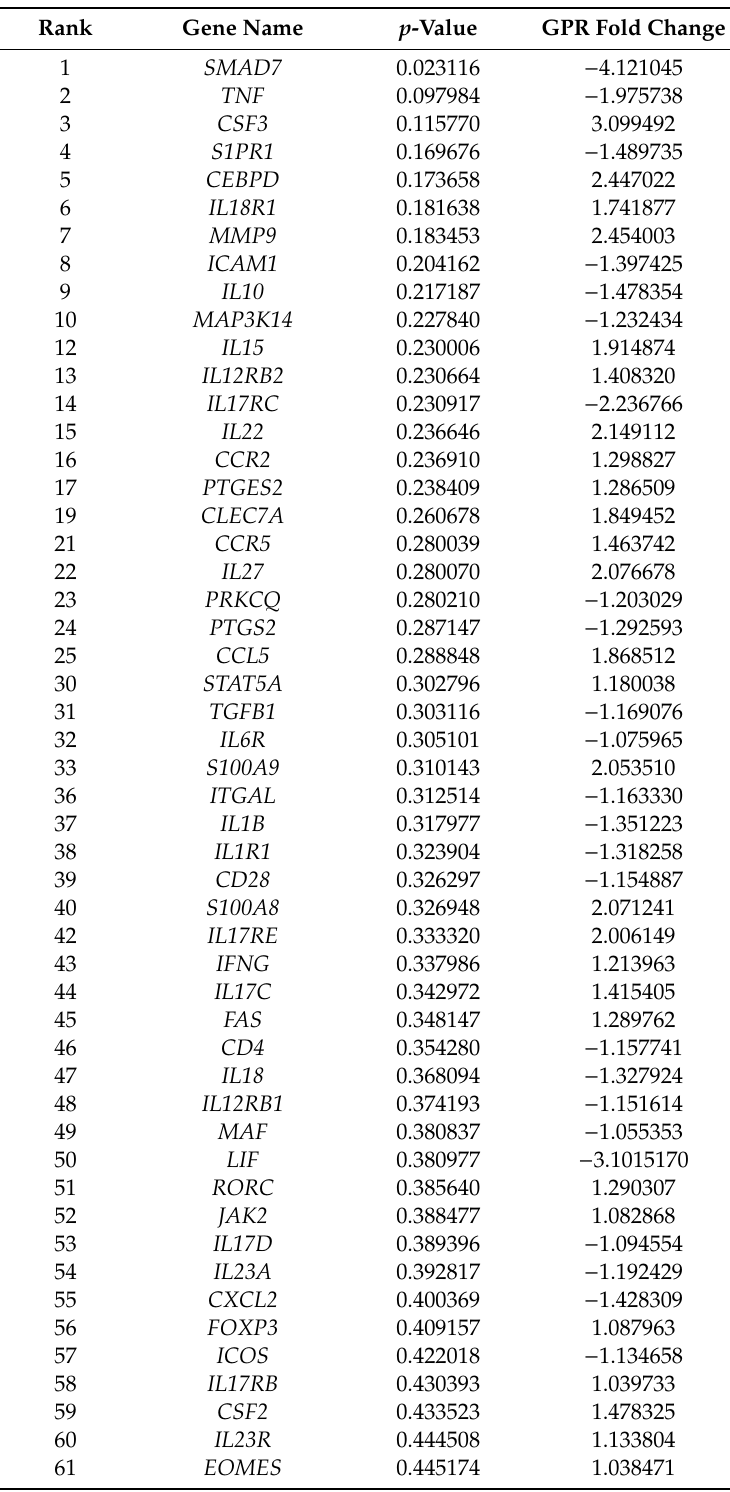
Table A1. Complete di ff erential expression data of genes included in the Human T helper 17 (Th17) 96 StellARray qPCR Array in healthy donors versus RRMS